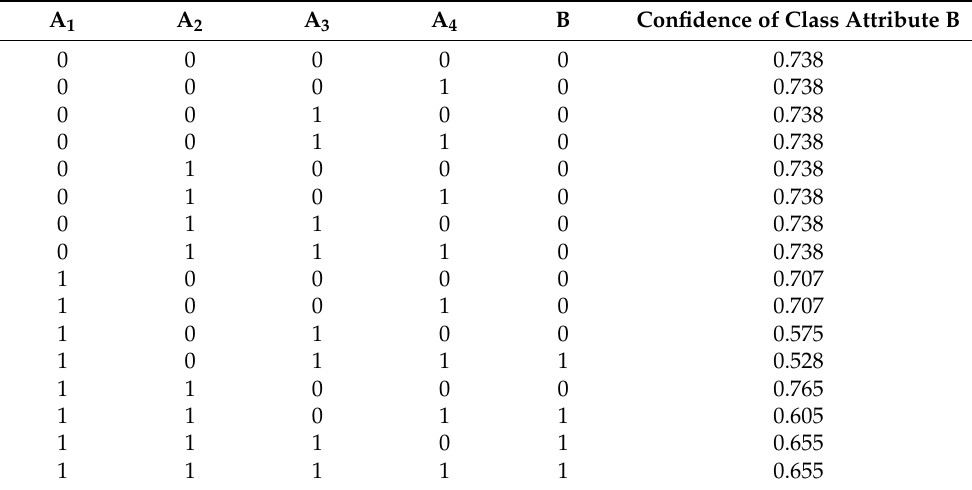
Table 4. Structure function of the simplified laparoscopic surgery